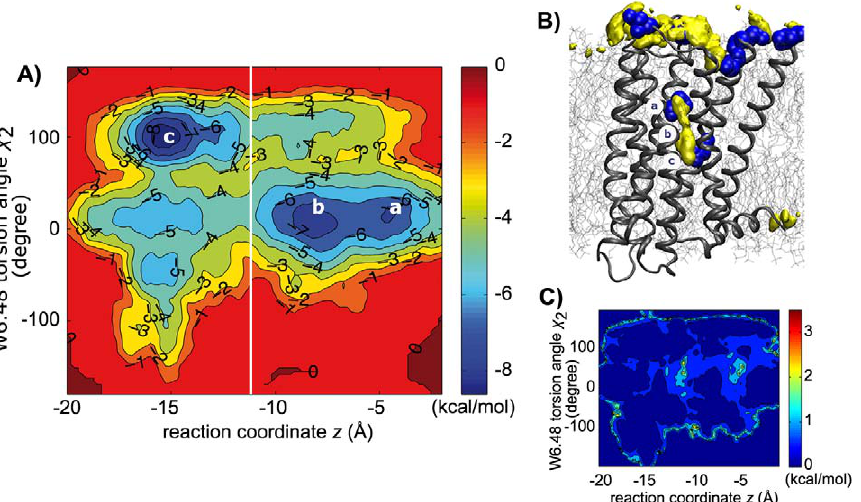
Figure 3. Free energy profile of sodium binding. (A) Two-dimensional free energy profile for ( z , x 2 ) reaction coordinates, where z is the z coordinate of the bound sodium ion and x 2 is the dihedral angle (CA-CB-CG-CD1) of tryptophan Trp6.48. The binding site a , b , c of the receptor show the pathway for sodium in the receptor and the locking of the tryptophan into the 100 degrees position (inactive state). The vertical white line shows the approximate position of Trp6.48. (B) Location of binding sites a , b , c in the D 2 receptor. (C) Associated absolute free energy error map of the free energy profile of (A) computed by 25 metadynamics runs of 14 ns each (MD3). All basins have sub-kcal/mol error while only higher hills in the free energy surface show more significant